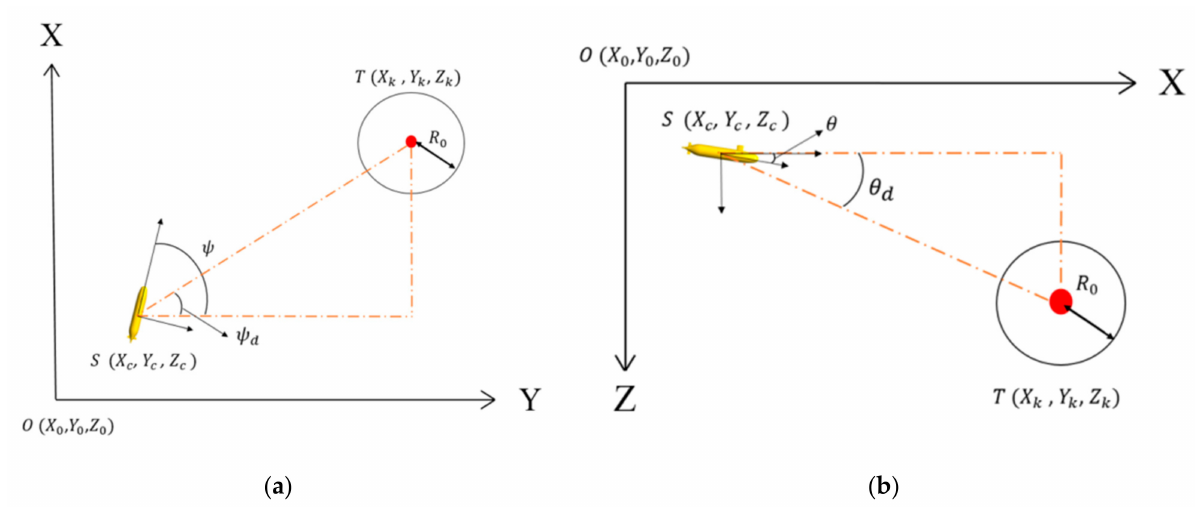
Figure 4. The schematic diagrams of the line-of-sight (LOS) guidance algorithm in ( a ) the horizontal plane and ( b ) the vertical plane, respectively.